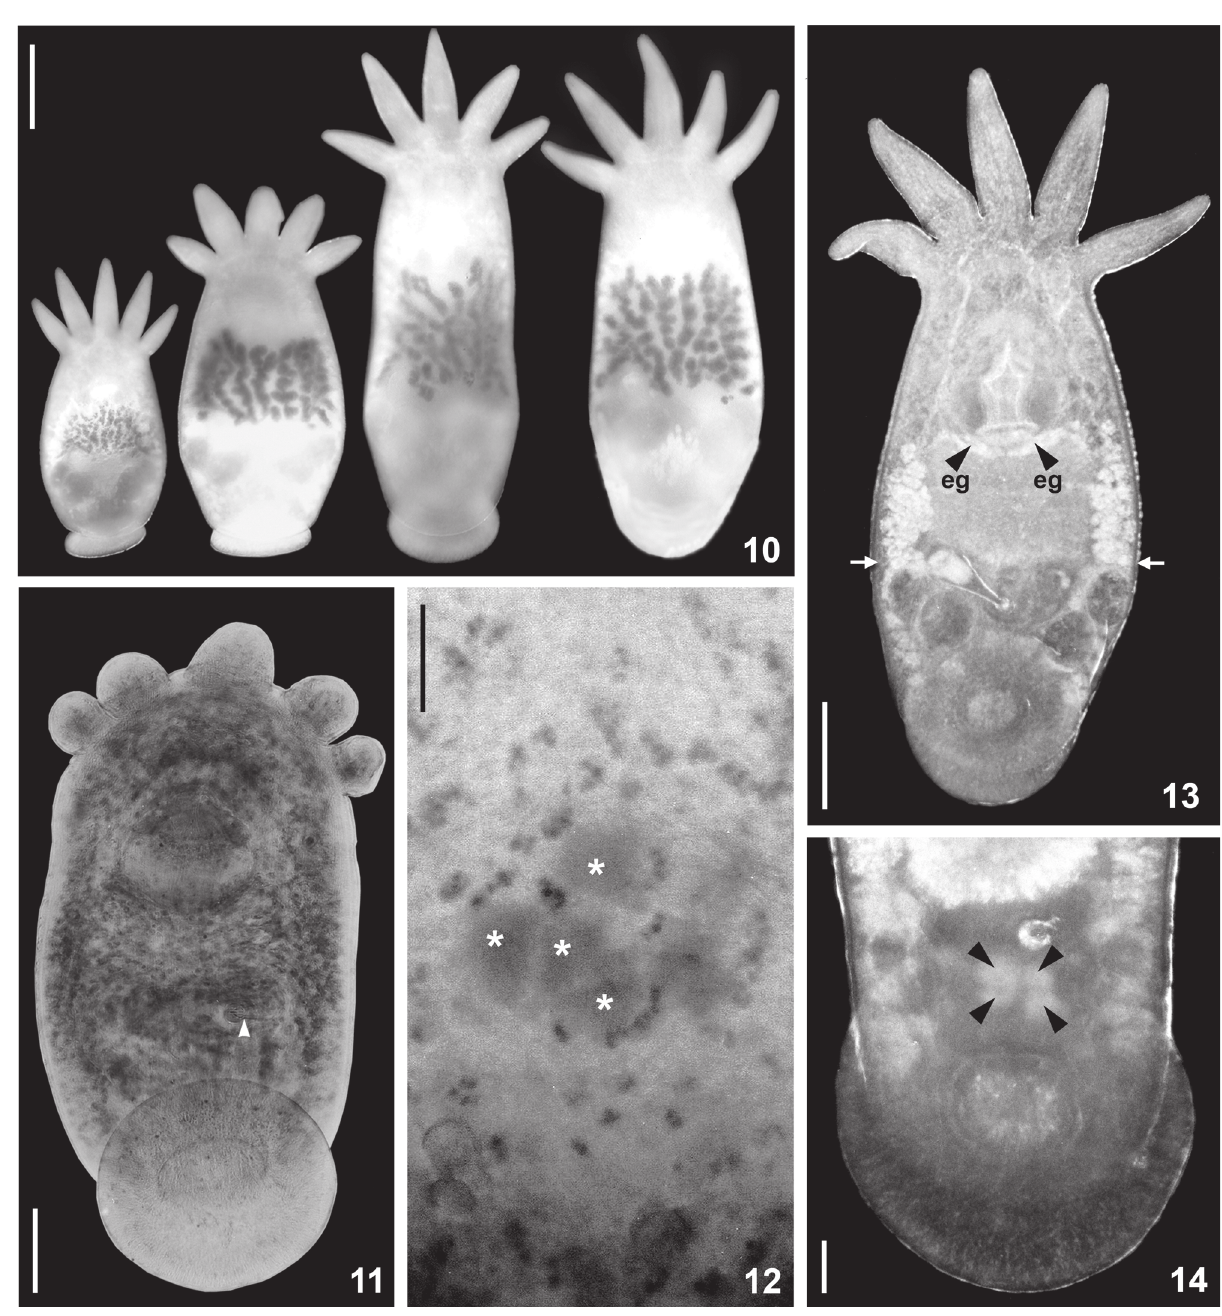
Figures 10-14. Temnocephala iheringi : (10) specimens fixed with hot formalin (HF), showing variations in body shape and absence of eyes, bar = 500 µm; (11) recently hatched juvenile, ventral view, showing the incipient straight cirrus (white head arrow), bar = 100 µm; (12) left group of Haswell glands (stars), bar = 50 µm; (13-14) specimens cleared in lactophenol; (13) entire specimen showing the limit between the anterior rhabditogenic glands and the posterior disc glands (white arrows), black head arrows (eg) indicating the esoph- ageal glands, bar = 250 µm; (14) posterior half of the body, showing two pairs of large disc glands (paranephrocytes?) (black head arrows), bar = 50